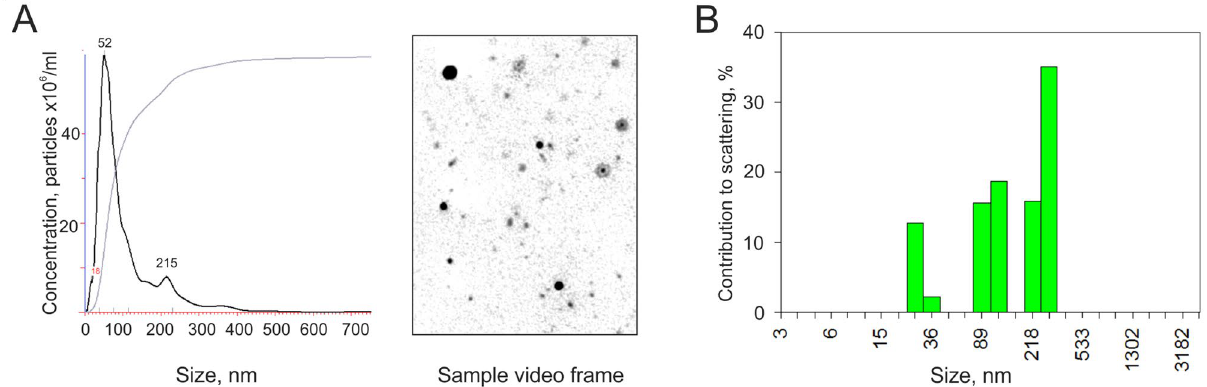
Figure 1. Characterization of grapefruit-derived particle size and concentration. ( A) Nanoparticle tracking analysis (NTA) of size and concentration in the sample of isolated GF-EVs. ( B) A typical example of the size distribution of isolated extracellular vesicles from grapefruit juice measured by dynamic light scattering (DLS). The majority of particles (90 ± 4% contribution by mass) had a size of about 30